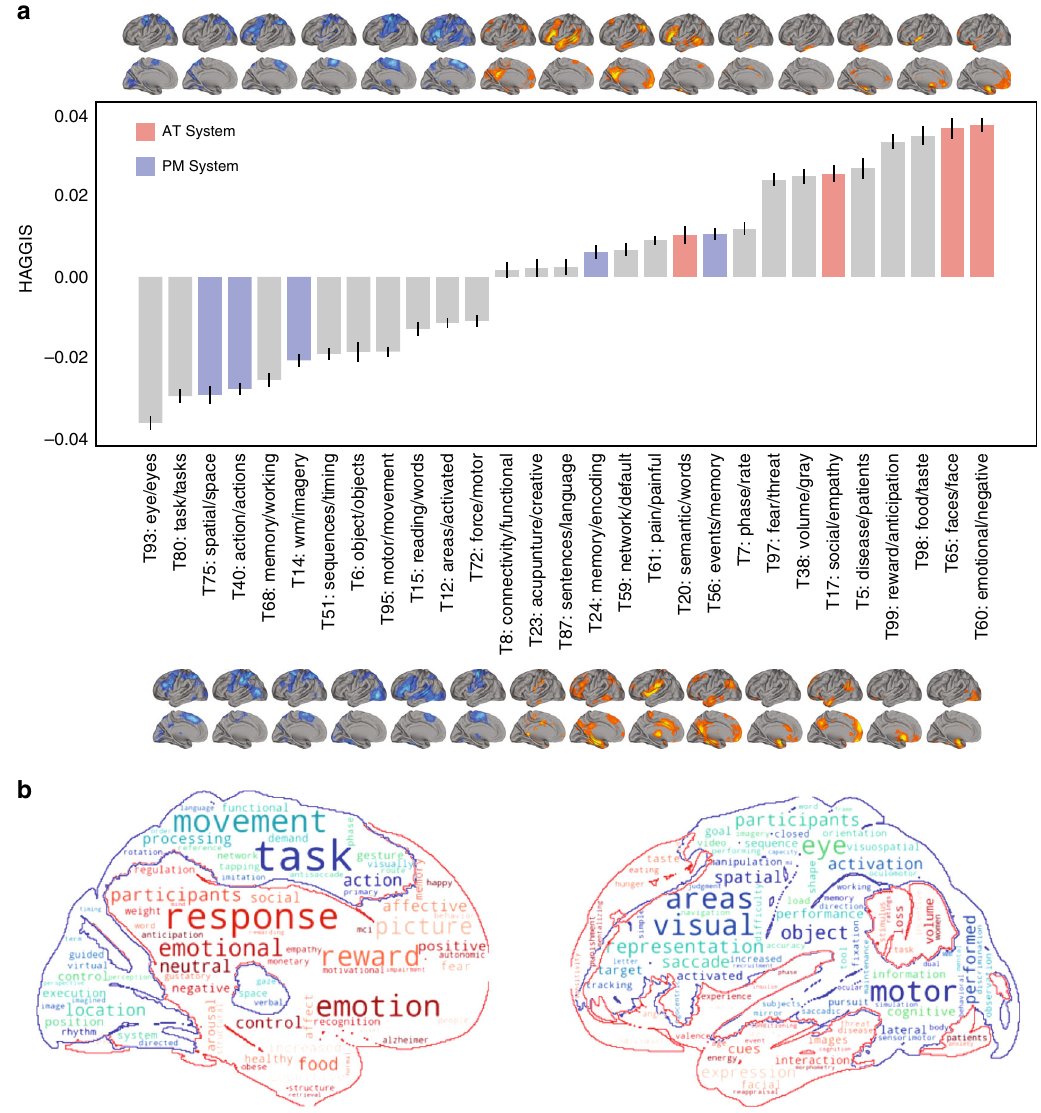
Fig. 6 Variation in genomic signature predicts involvement in distributed cognitive networks. a Maps were downloaded from neurosynth representing greater than chance meta-analytic functional activation in studies with different topic-sets mentioned in their text. Mean HAGGIS (represented by bars) was calculated for samples inside maps encompassing >500 samples (visualized either directly above or directly below each bar). Error bars represent standard deviation. Topics hypothesized to belong to the AT or PM system are shown in red and blue respectively. b A word cloud summarizing the regions and topics most associated with the genomic signal of the anterior (red) and posterior (blue) hippocampus. Larger words are more associated with networks with higher (red) or lower (blue)